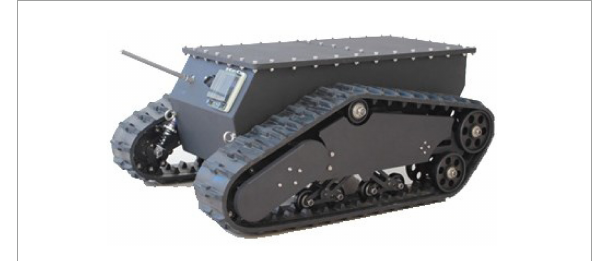
FIGURE4 Structure diagram of crawler chassis